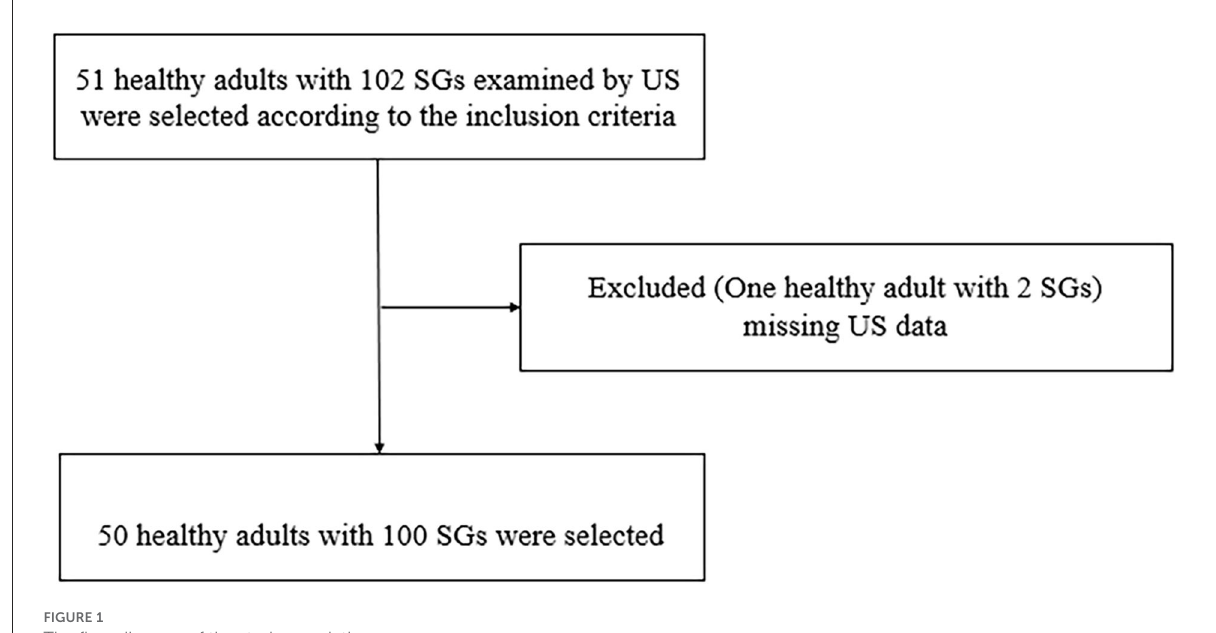
FIGURE1 The flow diagram of the study population.